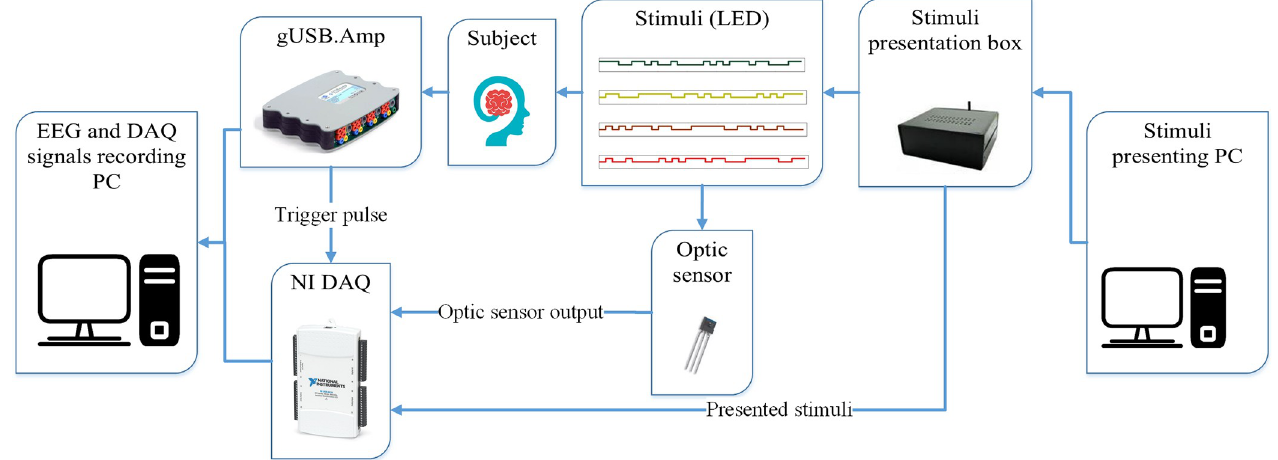
Fig 9. Signal recording set up: Stimuli were selected from stimuli presenting PC and sent to stimulator for presentation to subject via LED screen. NI DAQ was used to record the trigger pulse coming from g.USBAmp and optic sensor output and also the stimulator box. The data was sent to PC for further